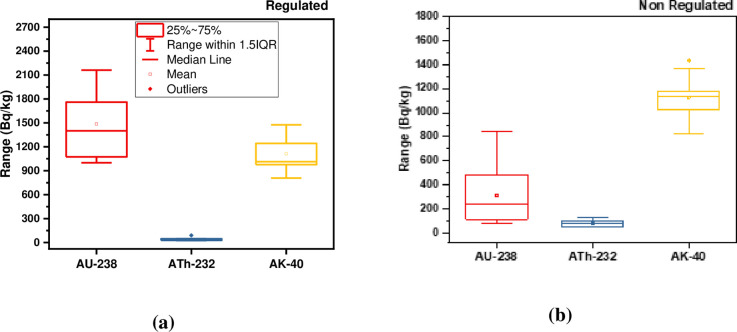
Box and whisker plot of 238U, 232Th, and 40K activity concentrations (Bq kg-1) in: (a) the regulated trenches and; (b) non- regulated trenches.